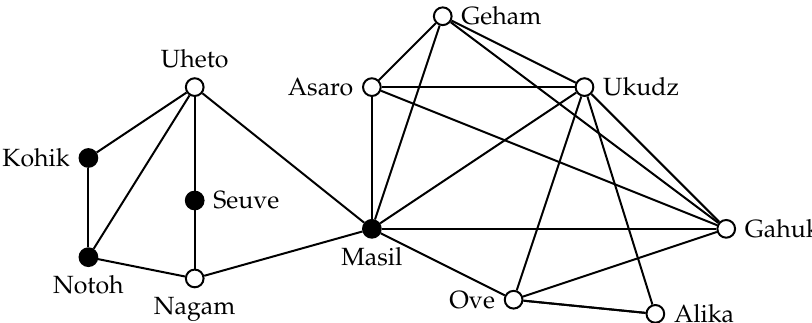
Figure 4. A part of the highland tribes social network [4]. The black vertices form a 2-clique that induces a disconnected